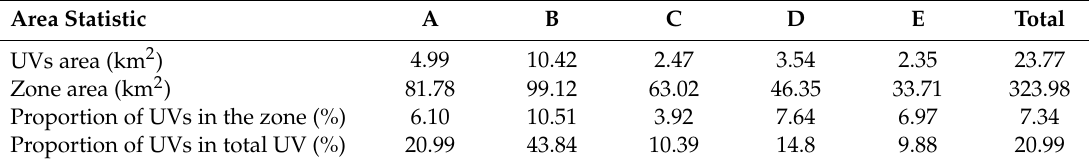
Figure 7. Classification result of UVs in the core area of Guangzhou. Table 5. Statistics on the UV-detection